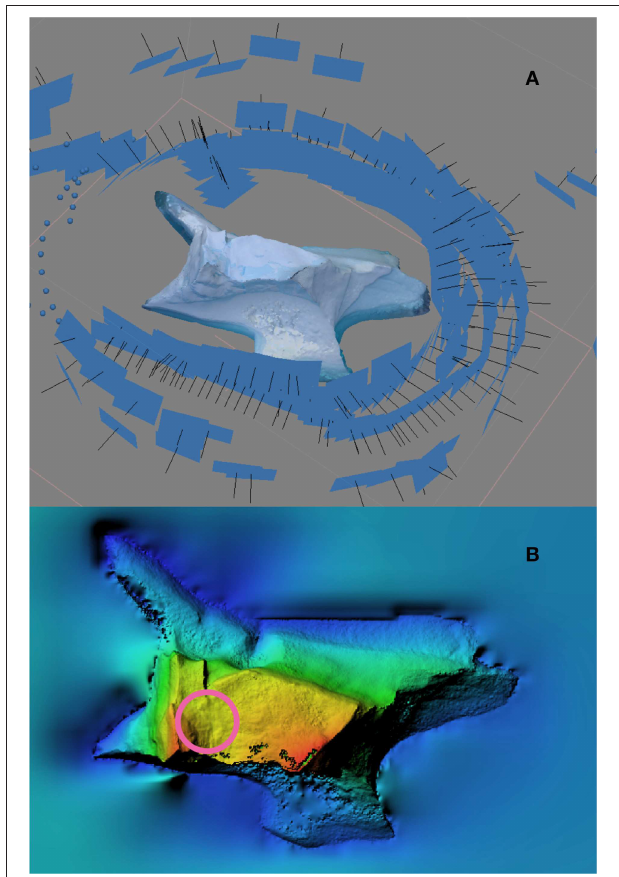
FIGURE 9 | (A) A high resolution 3D model constructed from 230 images that were processed in Agisoft Photoscan. The locations of aligned images are indicated by the blue rectangles. (B) The digital elevation model (DEM) produced by Photoscan with the sampling site indicated by the pink circle. Drone-generated DEMs could be used to select a suitable landing site in future autonomous versions of IceDrone.